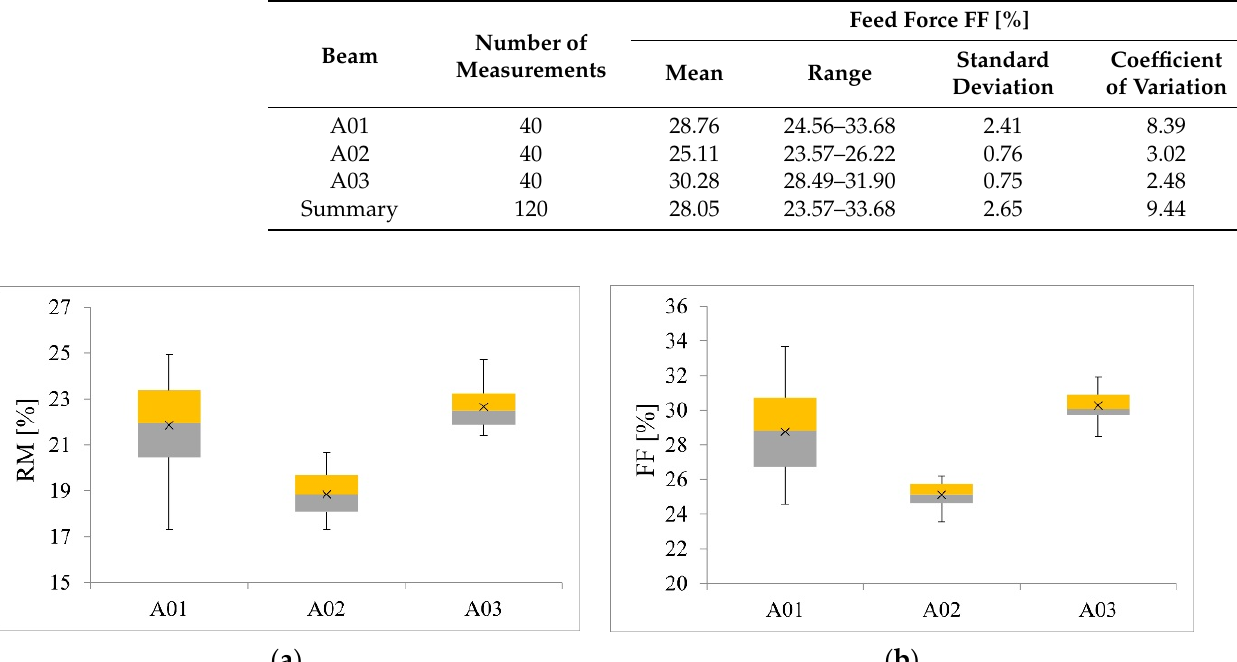
Table 9. Mean feed force test results.